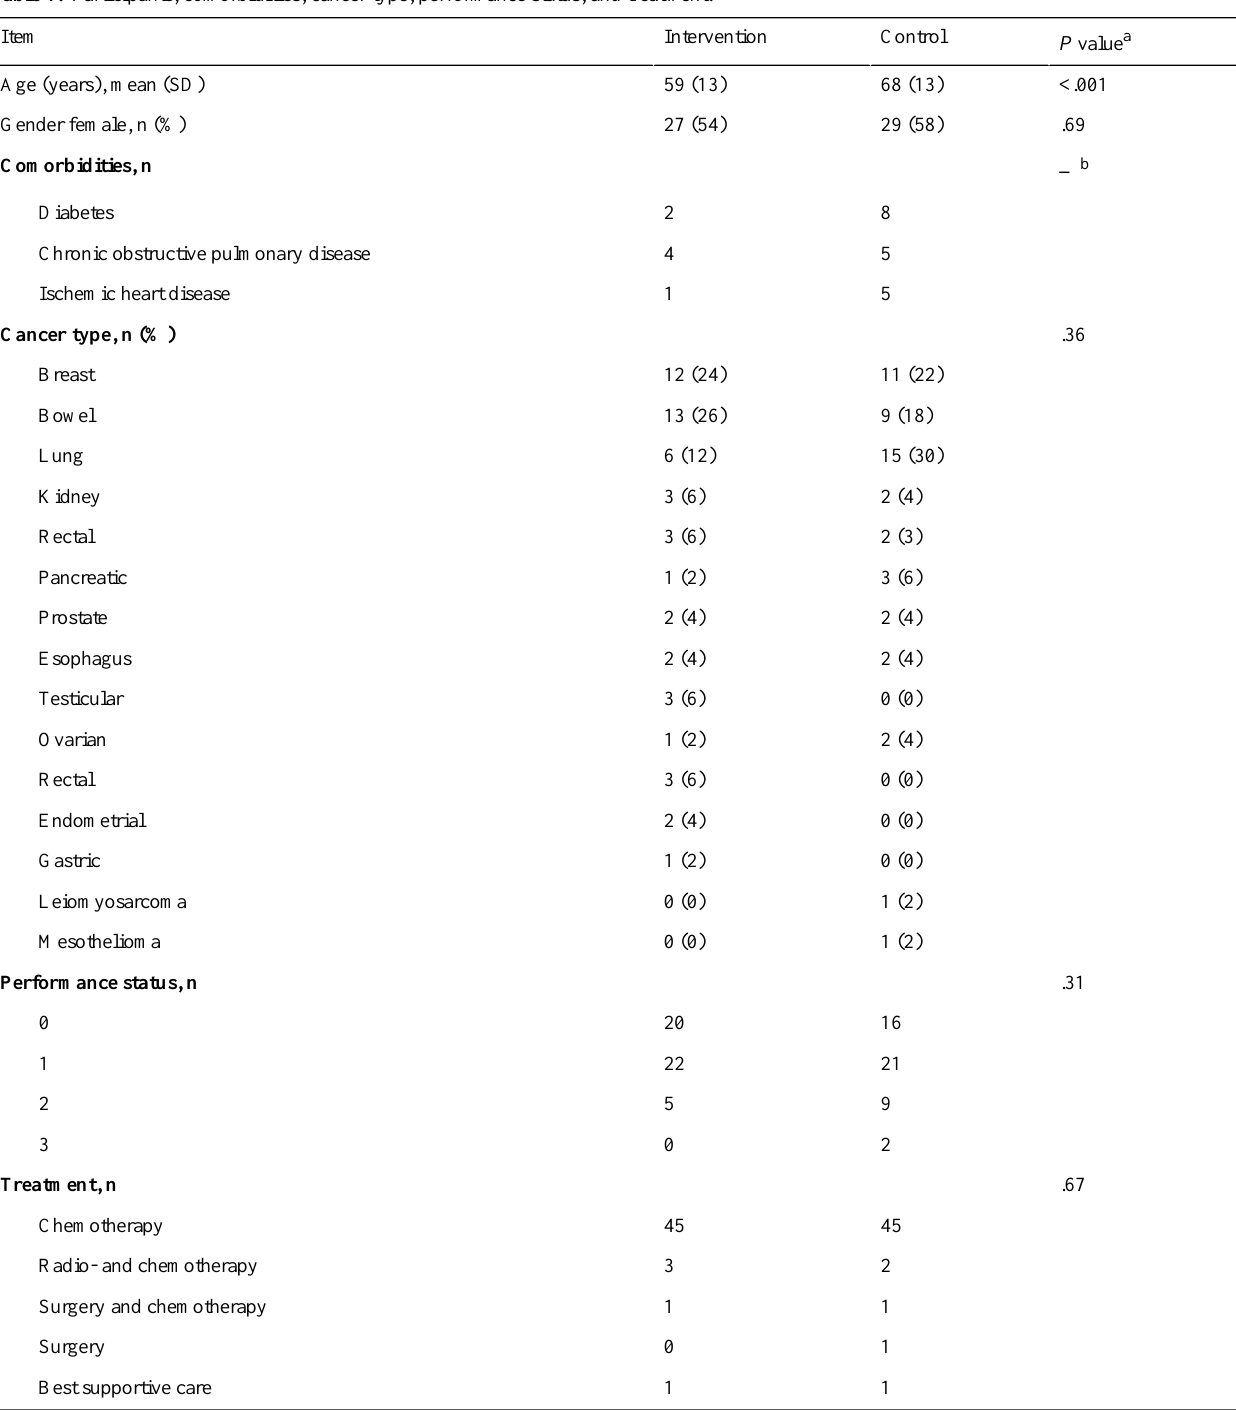
Table 1. Participants, comorbidities, cancer type, performance status, and